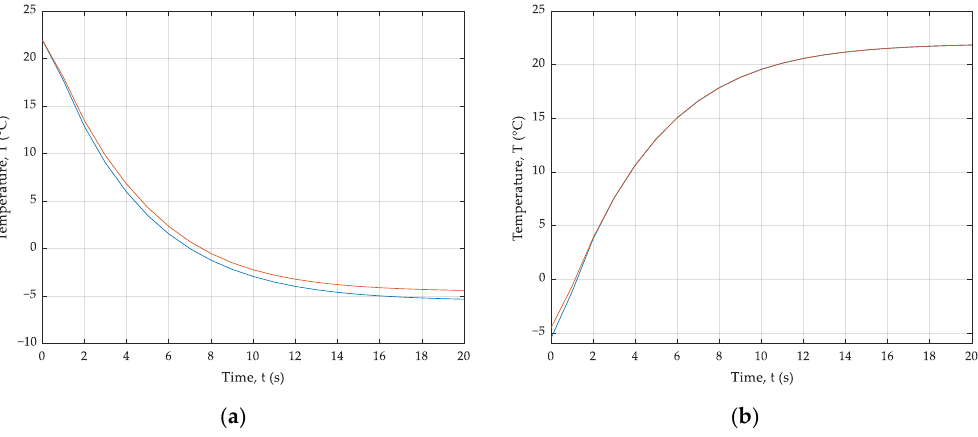
Figure 7. History of the temperature over time: ( a ) from 22 to −5 °C and ( b ) from −5 °C to 22 °C.